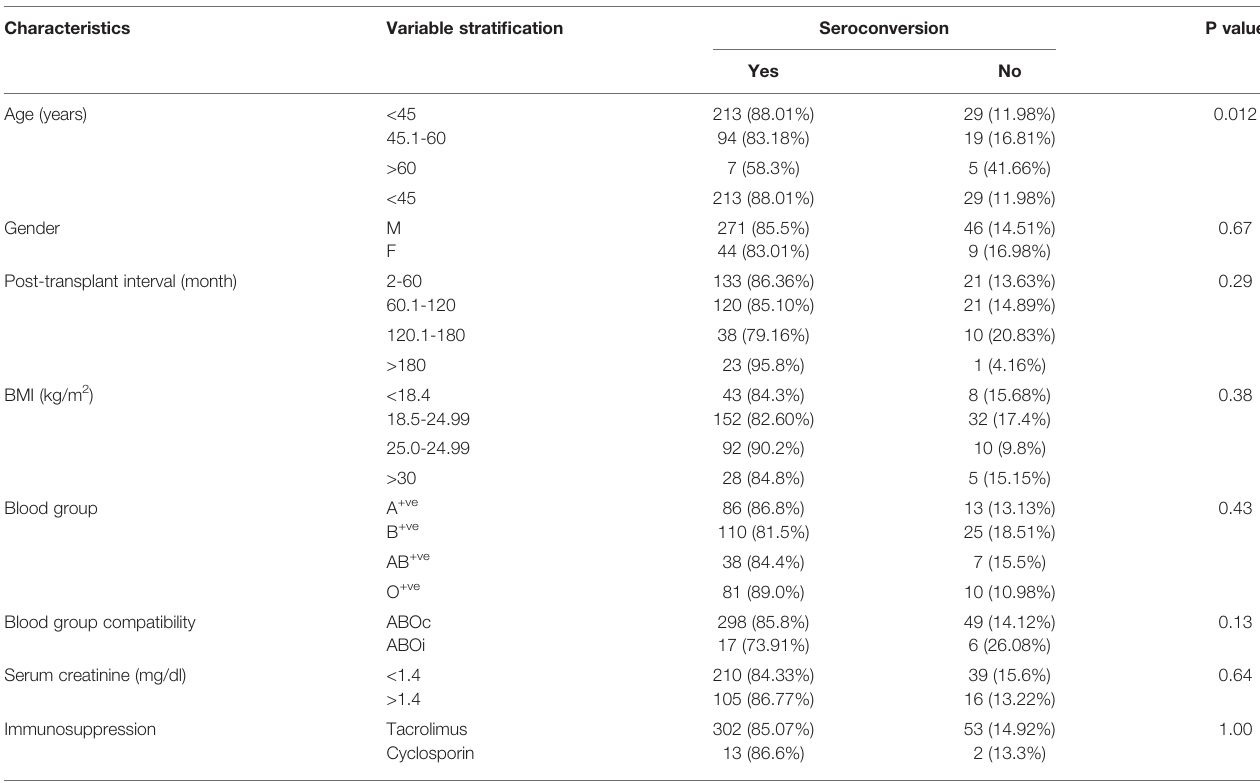
TABLE 4 | Clinical variables associated with seroconversion among the